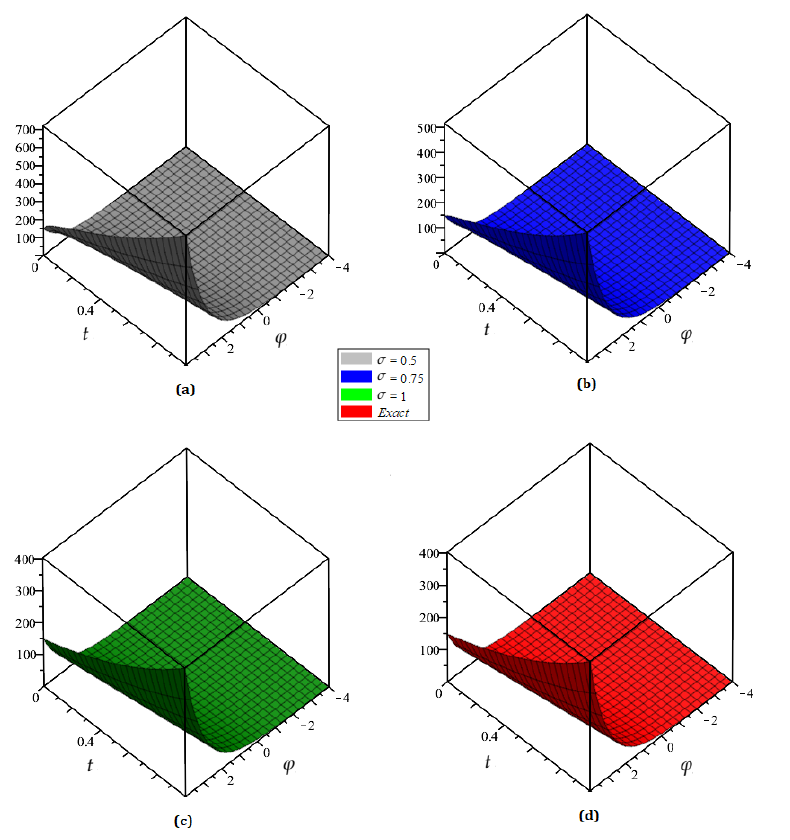
Figure 2. Three-dimensional plots of LRPSM solutions for u ( ϕ , ξ , t ) at distinct values of σ at ξ =